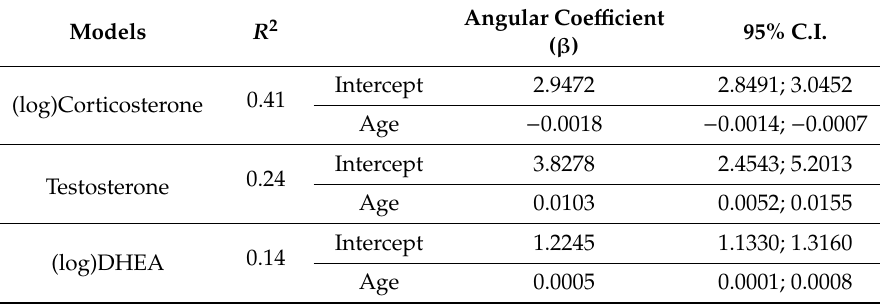
Table 2. Results of linear regression